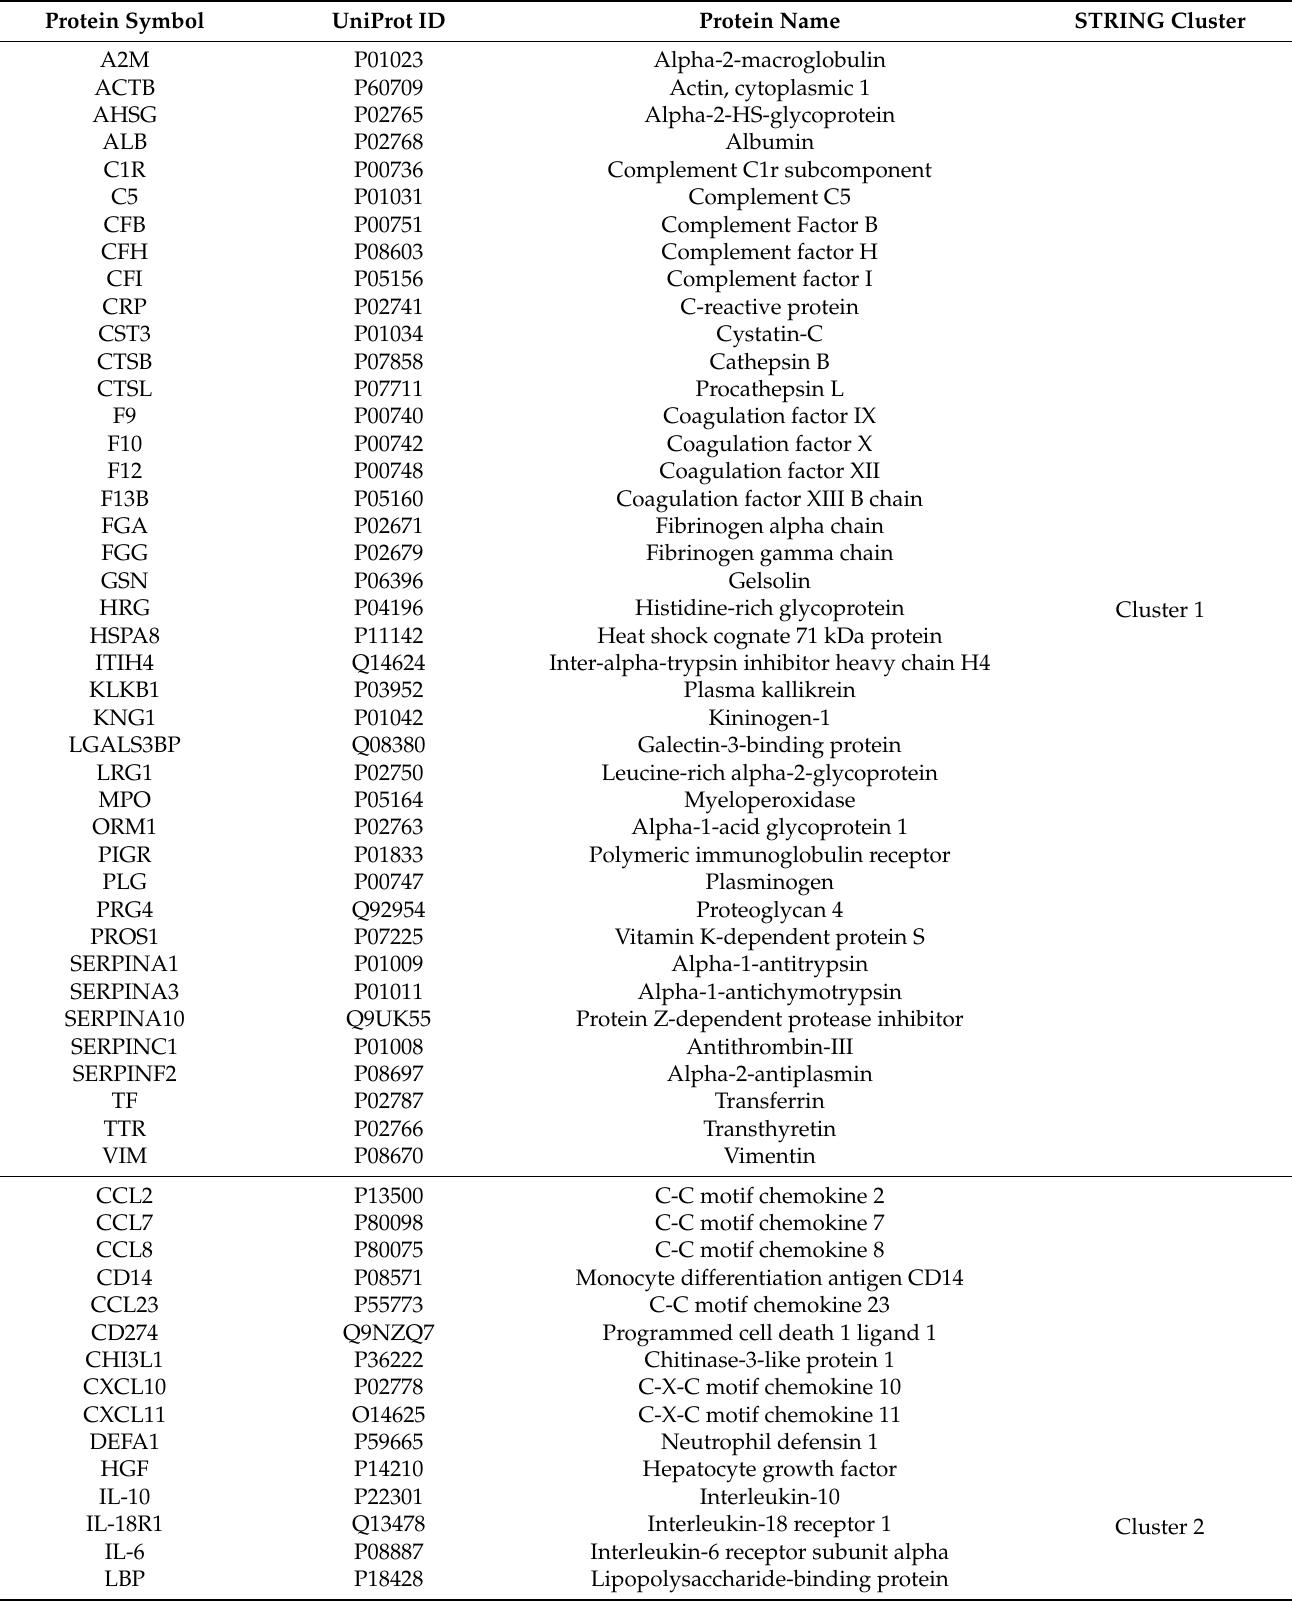
Table 4. The list of the proteins identified in more than one study characterizing the blood proteomic signature of